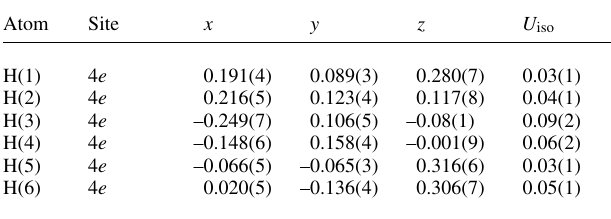
Table 13. Data collection and handling. Table 14. Atomic coordinates and displacement parameters (in Å 2 ) .